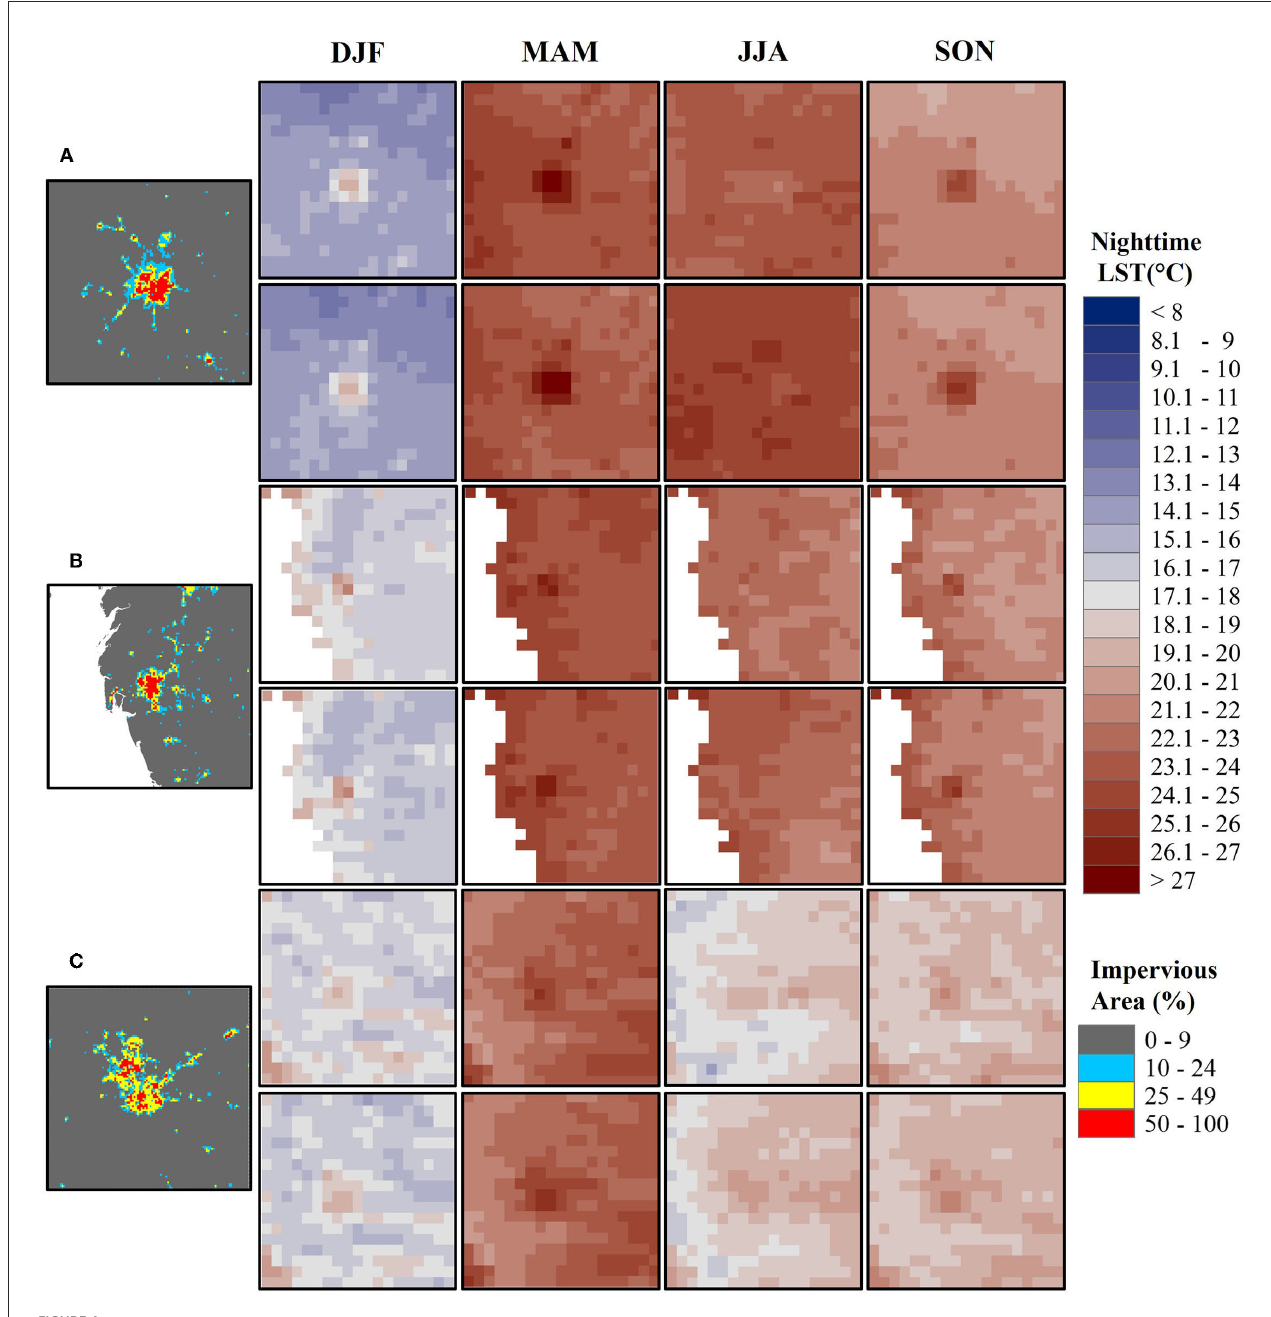
FIGURE4 Same as Figure 2, but for cities (A) Ahmedabad, (B) Surat, and (C)